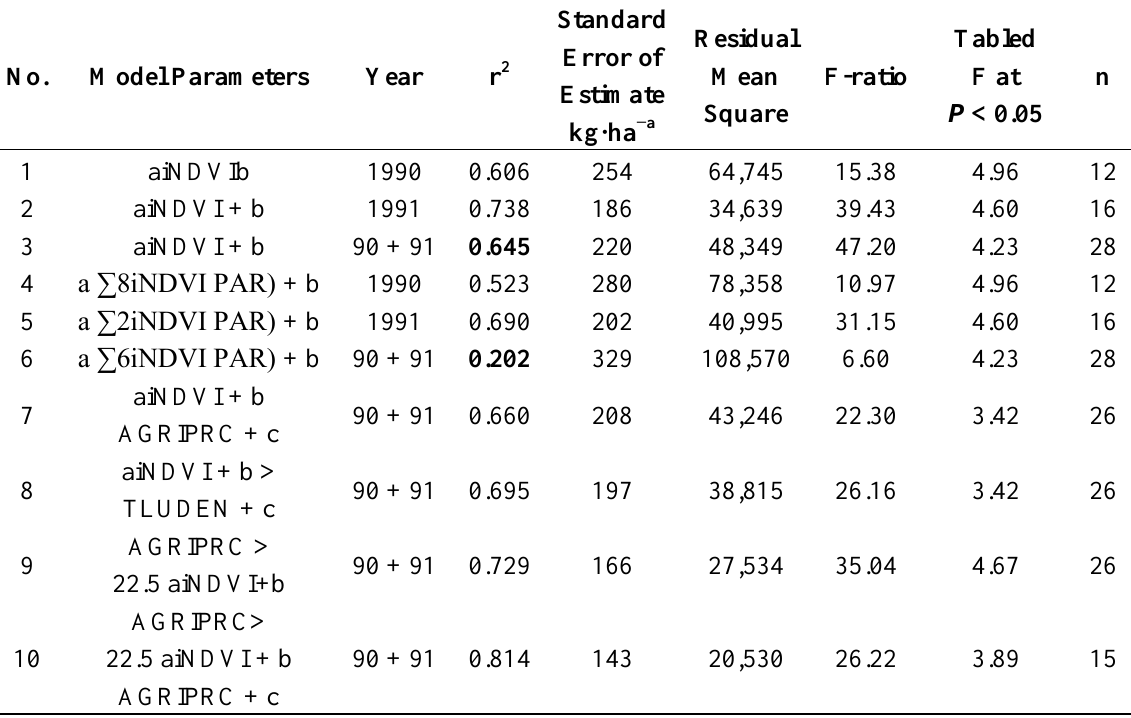
Table 2. Statistical summary of millet grain yield-integrated NDVI regression models for Senegal showing how the model can be improved by introducing additional bio-climatic variables like percentage of cultivated land (AGRIPRC) and Tropical Livestock Unit Density [63]. iNDVI is NDVI integrated from August to October, while iNDVI PAR is monthly values of NDVI and PAR (photosynthetically active solar radiation) multiplied and accumulated for the period July to